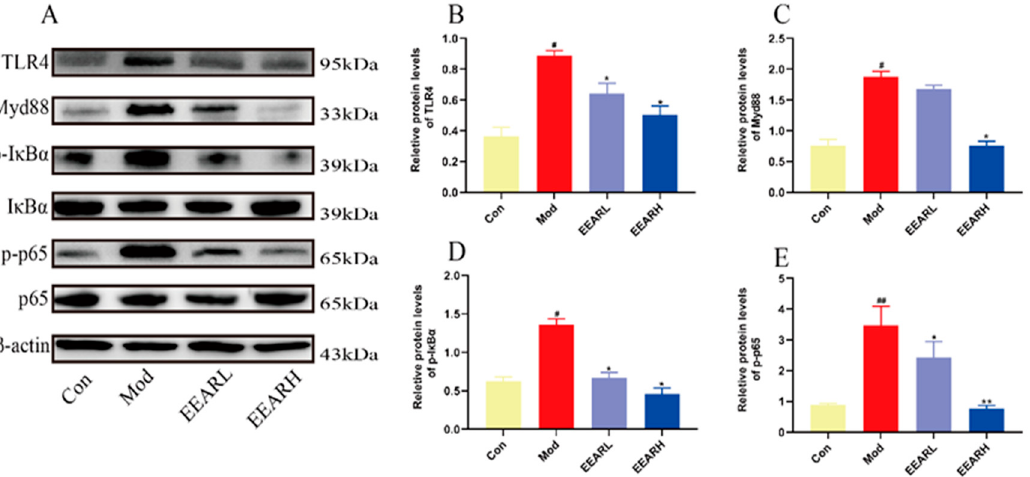
Figure 5. EEAR alleviated the extent of lung inflammation in rats with ALI by inhibition of the TLR4/NF- κ B signaling pathway ( n = 3). ( A ) TLR4/NF- κ B signaling pathway expression levels in lung tissue measured by Western blot analysis. ( B ) Quantitative analysis of differences in TLR4 levels in each group. ( C ) Quantitative analysis of differences in Myd88 levels in each group. ( D ) Quantitative analysis of differences in p-I κ B α levels in each group. ( E ) Quantitative analysis of differences in p-p65 levels in each group. Values are expressed as means ± SEM. ## p < 0.01 vs. Control; # p < 0.05 vs. Control; ** p < 0.01 vs. Model; * p < 0.05 vs. Model.